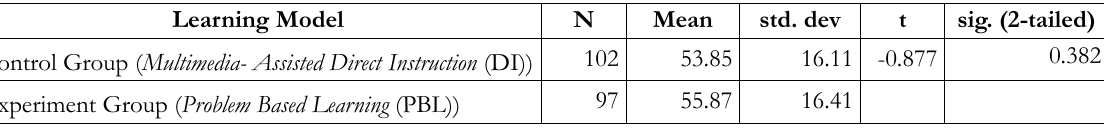
Table 6. The Independent Sample t-Test Learning Models for Initial